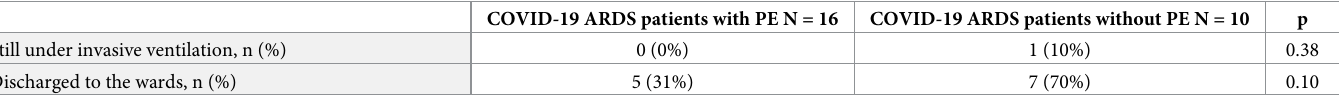
ARDS: Acute Respiratory Disease Syndrome; BMI: Body Mass Index; COVID-19: Coronavirus disease 2019; CTPA: Computed Tomography Pulmonary